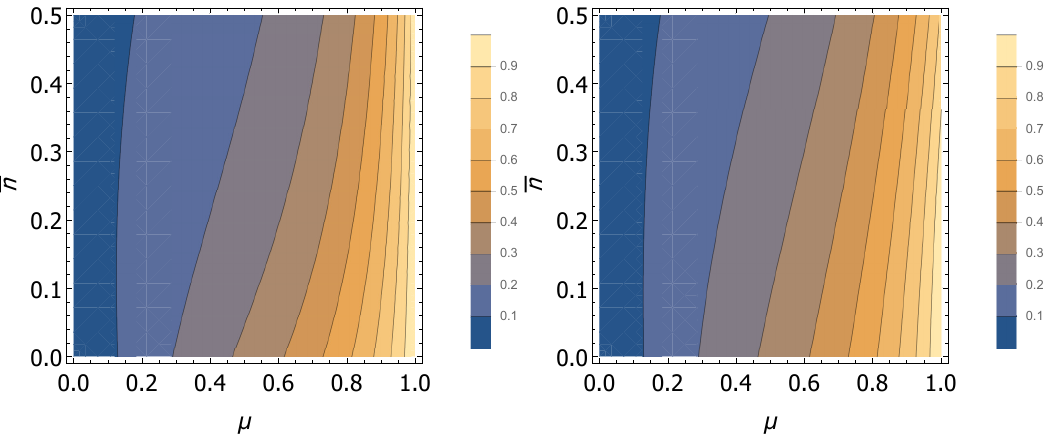
Figure 9. Plots of the fidelity F between the detected state and a quantum vortex | 1 + (cid:105) for a realistic detection system with dark counts of thermal ( left ) and Poissonian ( right ) origin. Left : F vs. ¯ n th - µ with s = 0.7. Right : F vs. ¯ n pa - µ with